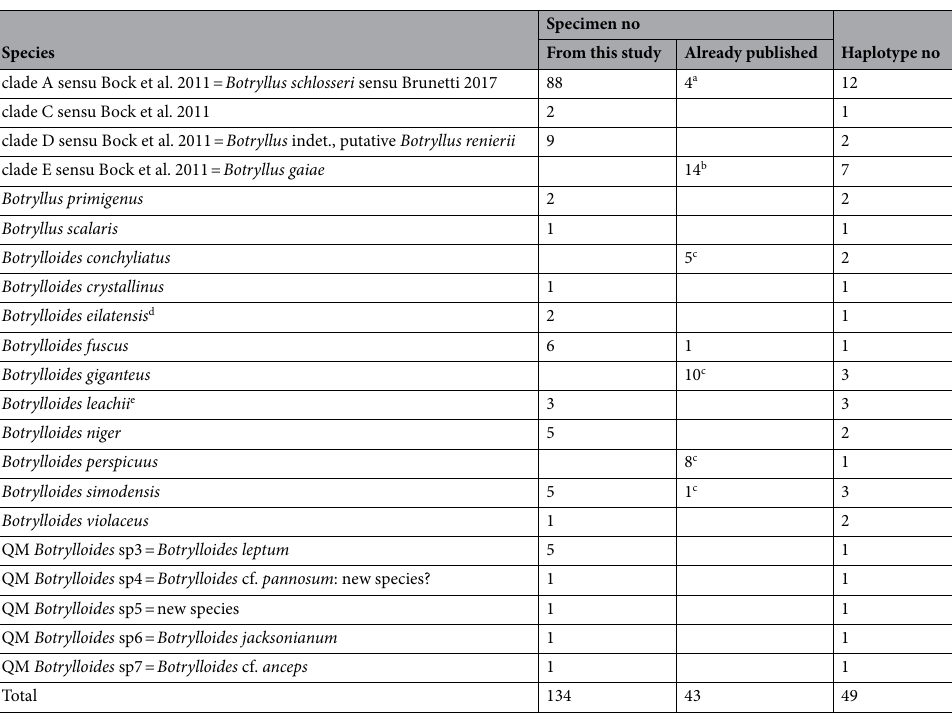
Table 3. Botryllinae species characterized by the 860-COI fragment in this and in previous studies. a In 39